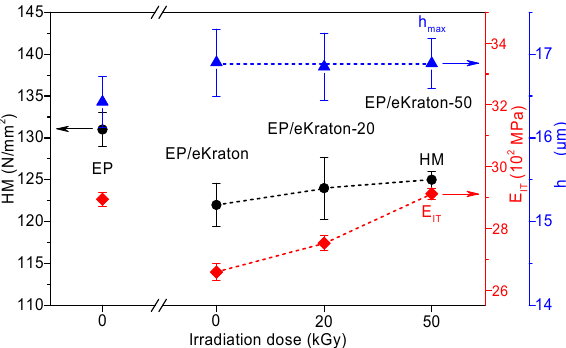
Figure 9. Hardness (HM), indentation modulus (E IT ), and maximum indentation depth (h max ) of EP/eKraton blends modified with different irradiation doses compared with the neat epoxy thermoset.